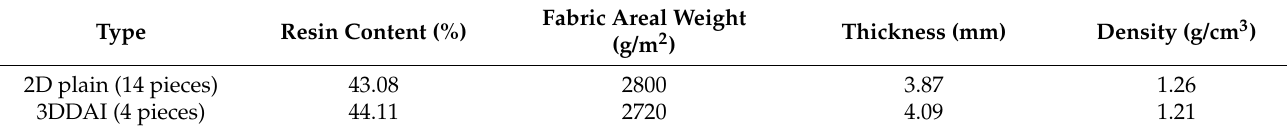
Table 8. 3DDAI armor material, 2D plain laminated armor material